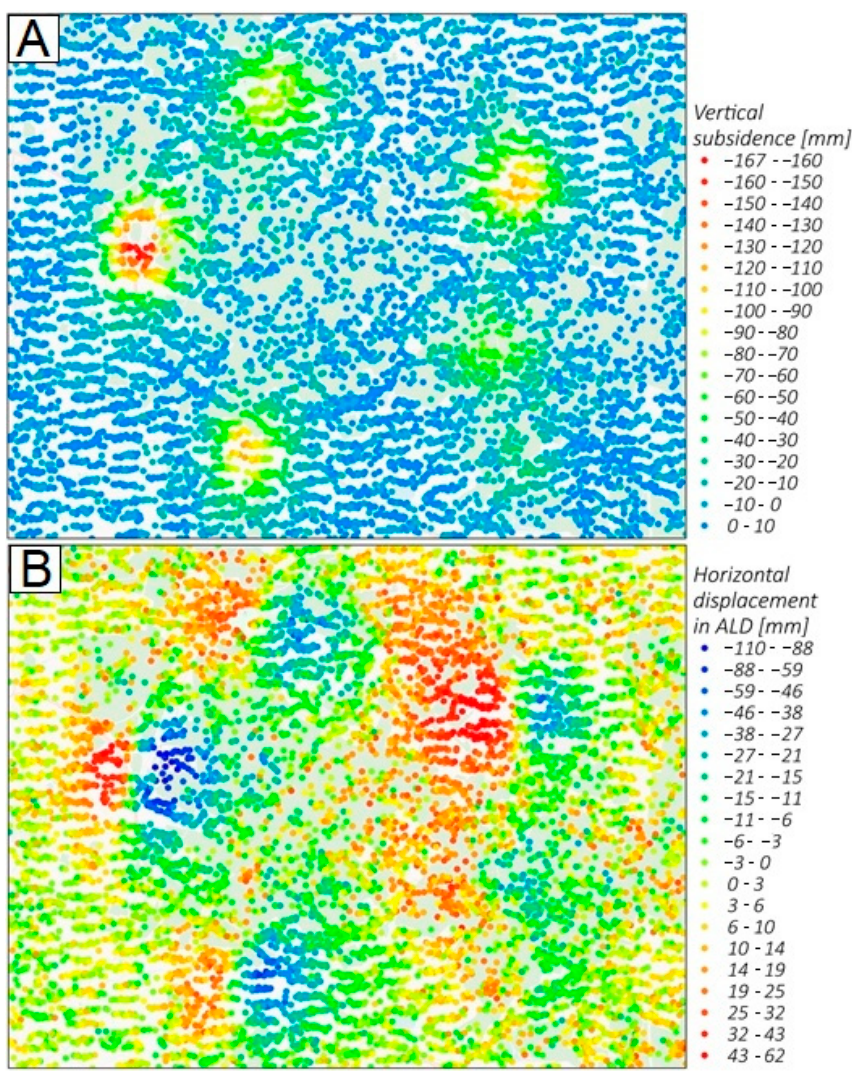
Figure 6. The results of the LOS decomposition into the vertical ( A ) and ALD horizontal ( B ) compo- nents of the land surface displacement field in the case study.